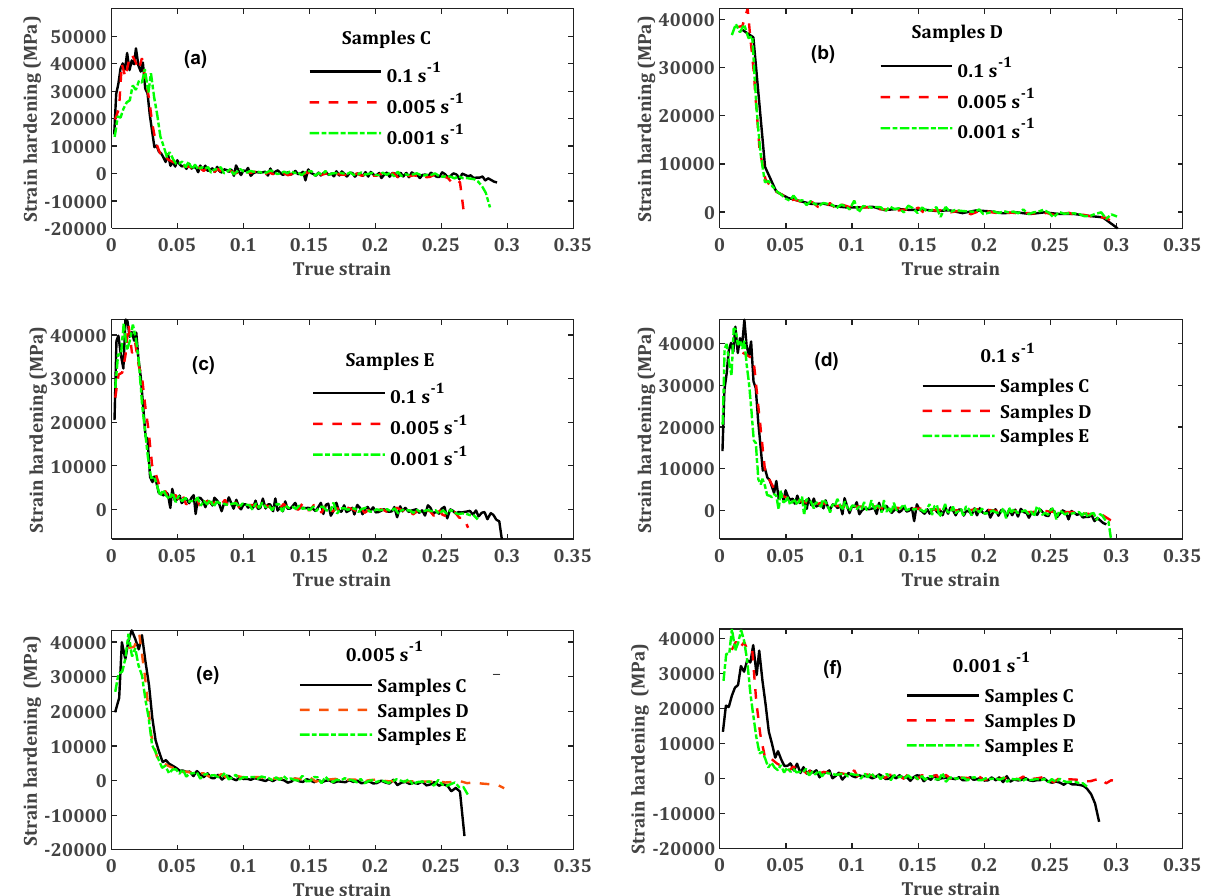
Figure 13. The variation of strain hardening with strain for samples ( a ) C, ( b ) D and ( c ) E, while ( d ), ( e ) and ( f ) show the comparison of strain hardening in the three different categories of samples at strain rates of 0.1 s − 1 , 0.005 s − 1 , and 0.001 s − 1 , respectively.